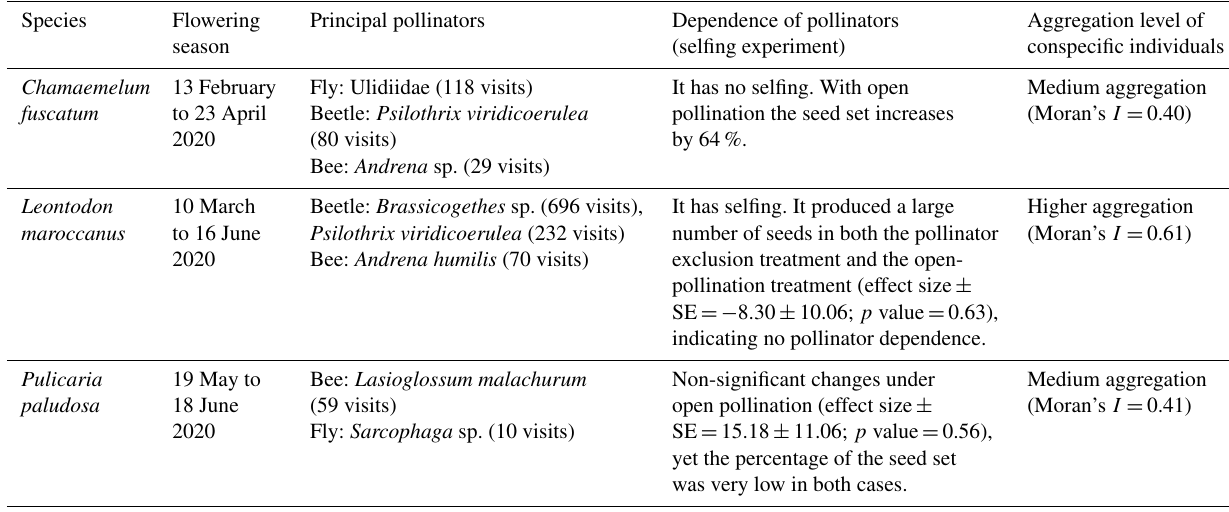
Table A4. Summary of the most relevant characteristics (flowering season, principal pollinators, dependence of pollinators and the aggrega- tion level of conspecific plant individuals) of the three main plant species: Chamaemelum fuscatum , Leontodon maroccanus and Pulicaria paludosa .